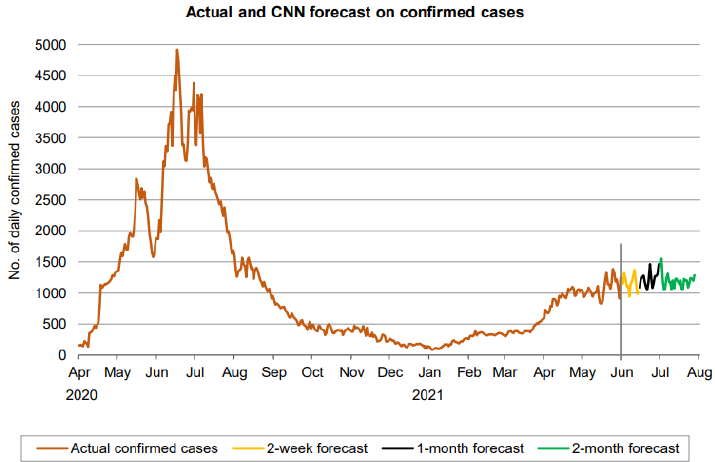
Figure 17. Prediction over a 60-day forecast for confirmed cases using the CNN